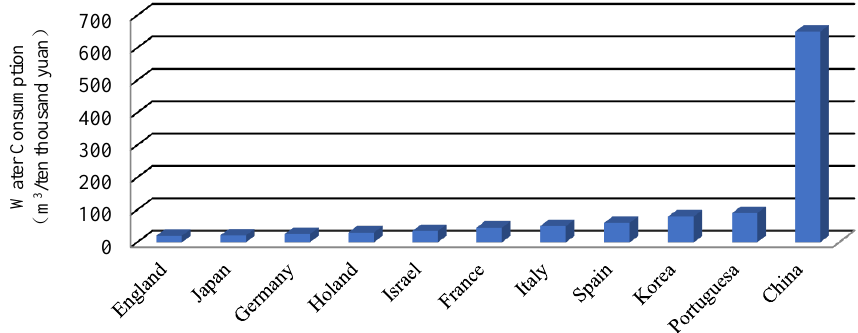
Figure 6. Water consumption per unit of GDP in some countries.